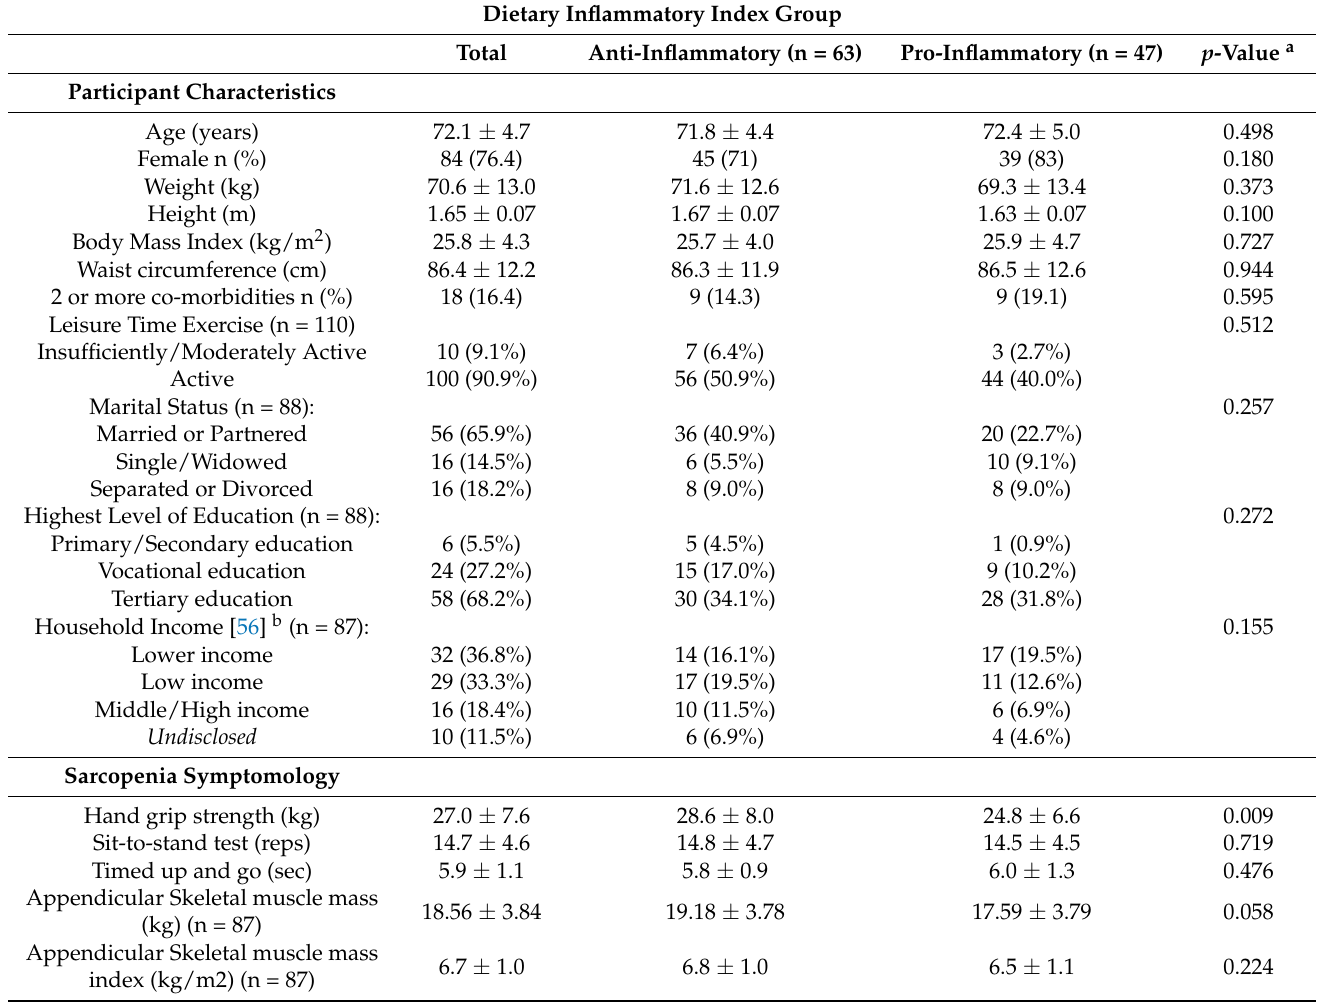
Table 1. Participant characteristics of total group and dietary inflammatory index